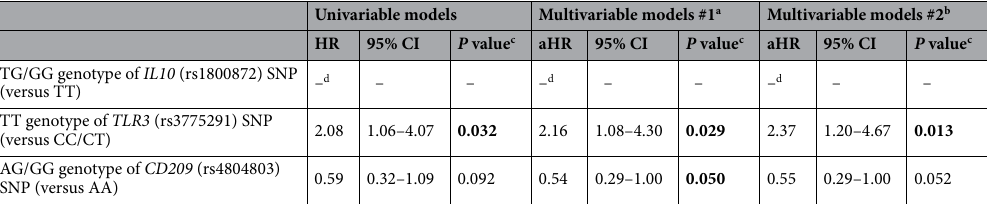
Table 5. Univariable and multivariable Cox regression models assessing the impact of selected SNPs on the incidence of BKPyV viremia during the post-transplant follow-up period. aHR adjusted hazard ratio; CI confidence interval; IL interleukin; SNP single-nucleotide polymorphism; TLR toll-like receptor. a Model #1 adjusted for recipient age, pre-transplant coronary heart disease, pre-transplant renal replacement therapy and donation after circulatory death (Table S1). b Model #2 adjusted for recipient age, pre-transplant coronary heart disease, pre-transplant renal replacement therapy, donation after circulatory death, acute graft rejection (time-dependent covariate), estimated glomerular filtration rate and tacrolimus trough levels by month 3. c Bold characters indicate significant P values. d HRs were not estimable since all the cases of BKPyV infection occurred in recipient bearing TG/GG genotypes.